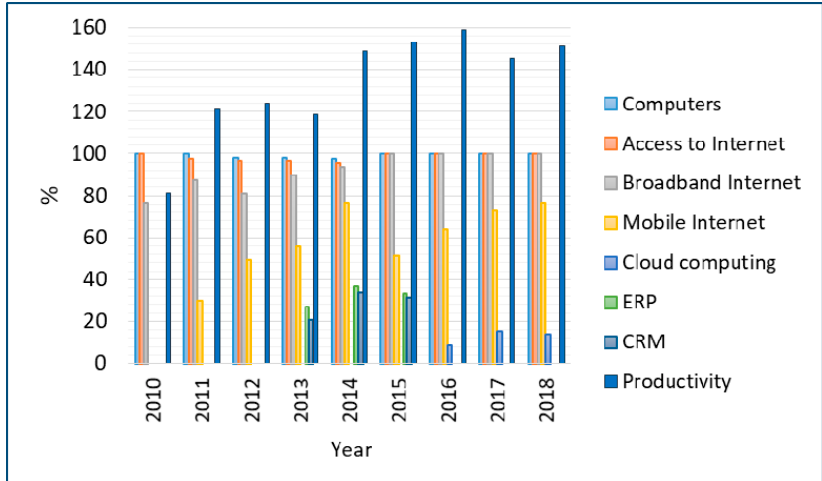
Figure 2. ICT and labour productivity in the steel industry (manufacturers of basic metals) in Poland. Source: Data from GUS [122].